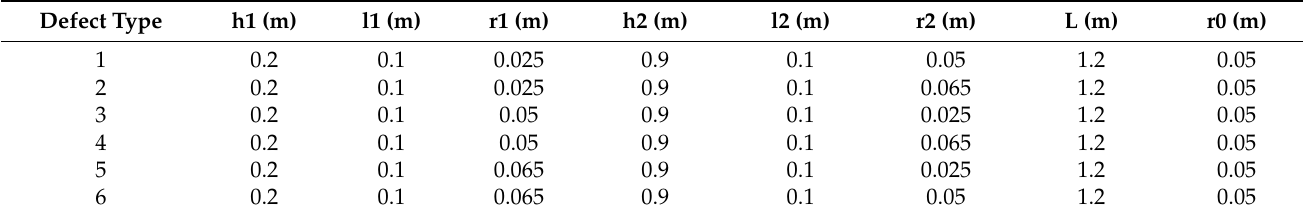
Table 3. Parameters of defective pile for